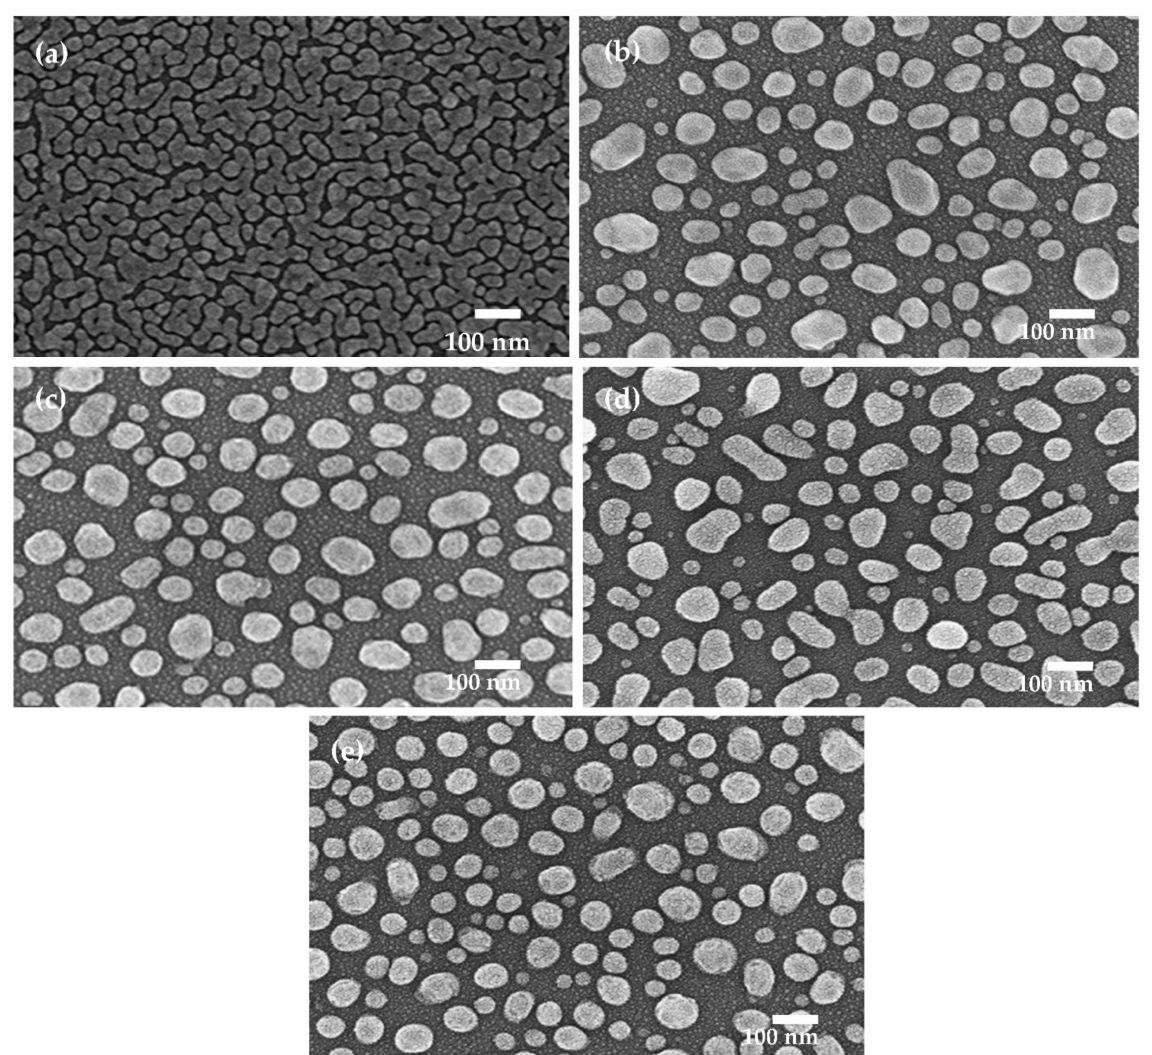
Figure 2. Surface morphologies of ( a ) the Ag film directly deposited onto the silicon substrate and the films annealed at ( b ) 300, ( c ) 400, ( d ) 500, and ( e ) 600 ◦ C under nitrogen ambient for 1 min, conducted by FE-SEM